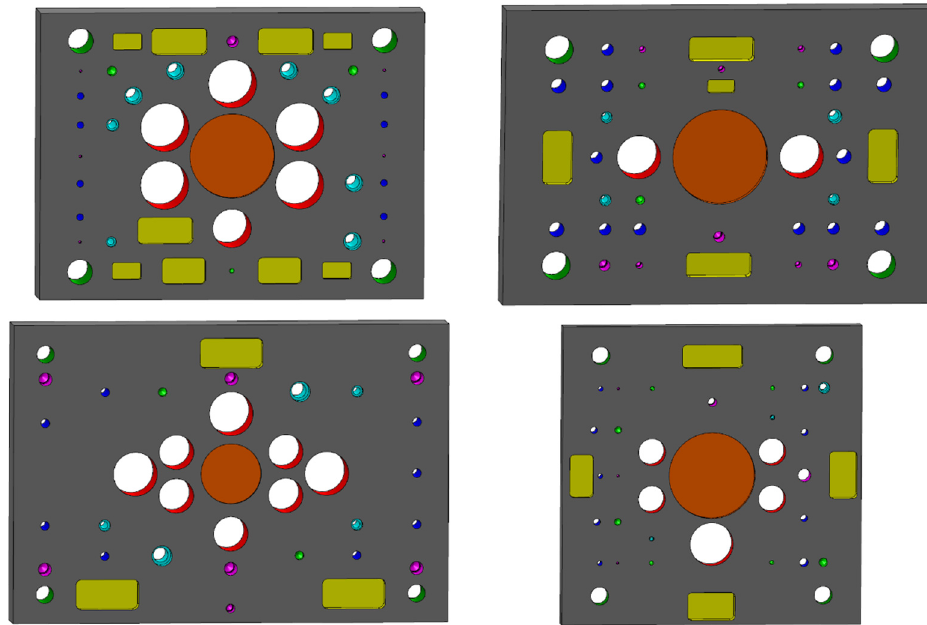
Figure 2. Examples of models used to produce the mold parts (Figure S1).